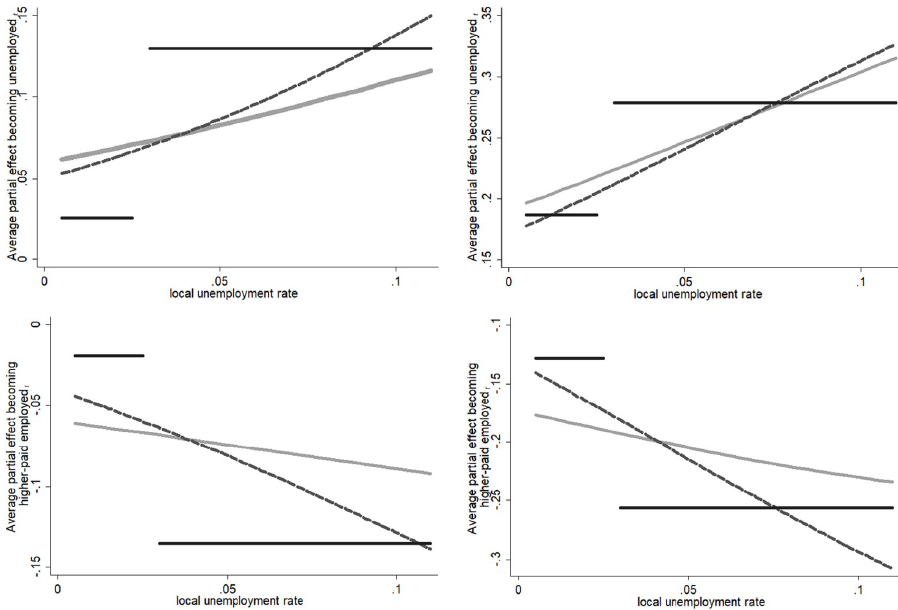
Fig 3. Average partial effect of becoming unemployed (upper panel), resp. higher-paid (lower panel) employed, at t . Source : Understanding Society (2015), Waves 1–5, 2009–2014; linked with DfT Accessibility Statistics 2013. The panel on the left shows the APE between someone short-term unemployed and someone low-paid employed at t-1 of becoming unemployed (top), resp. higher-paid employed (bottom); the panel on the right refers to the long-term unemployed. Model 1 includes the local unemployment rate in continuous form, Model 2 relaxes the assumption of effect heterogeneity for different labour market positions and Model 3 includes a dichotomous indicator for low vs. high local unemployment. Model (1): grey line; Model (2) dashed line; Model (3): black line.